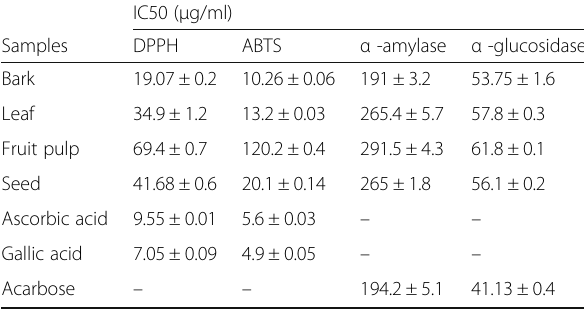
Table 8 Free radical scavenging activities of S. caryophyllatum bark, leaf, fruit pulp, seed methanol extracts and standard antioxidants (Ascorbic acid and Gallic